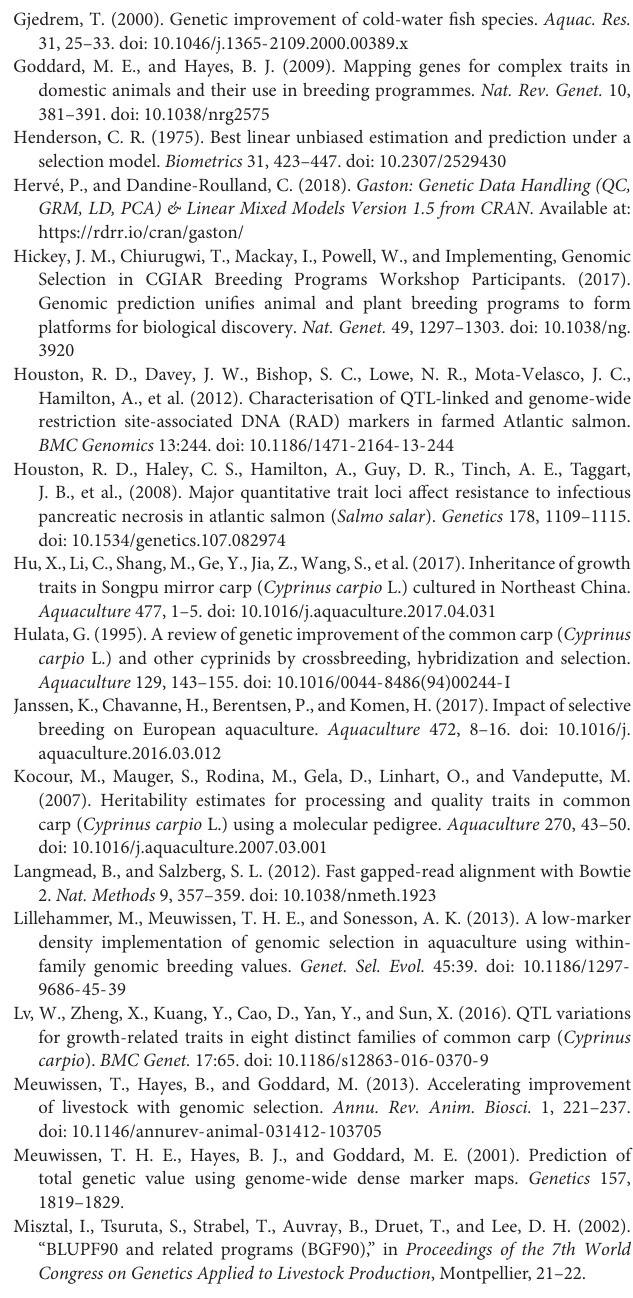
TABLE S1 | Parentage and phenotypic information of juvenile common carp. TABLE S2 | Detailed information of identified SNP through RADseq. TABLE S3 | Linkage map of common